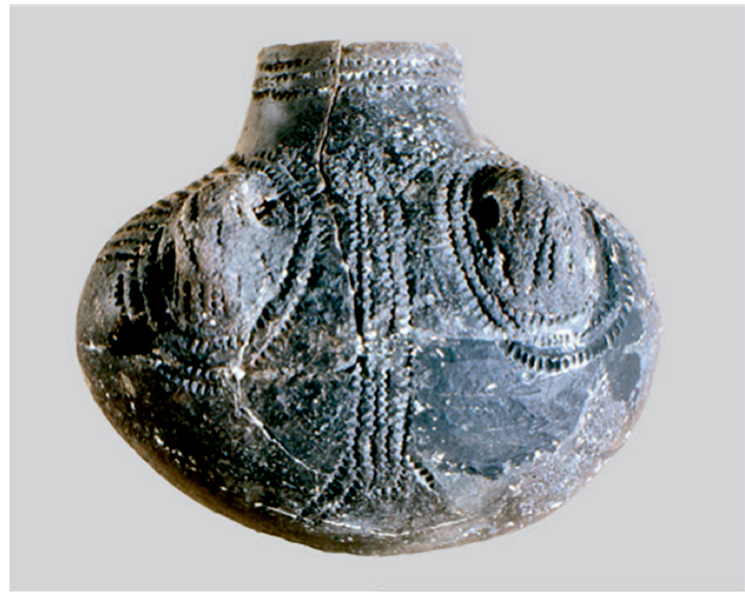
Figure 2. Printed “cardial” cup from the Cova de l’Or. Photography: Museu de Prehistòria de València.